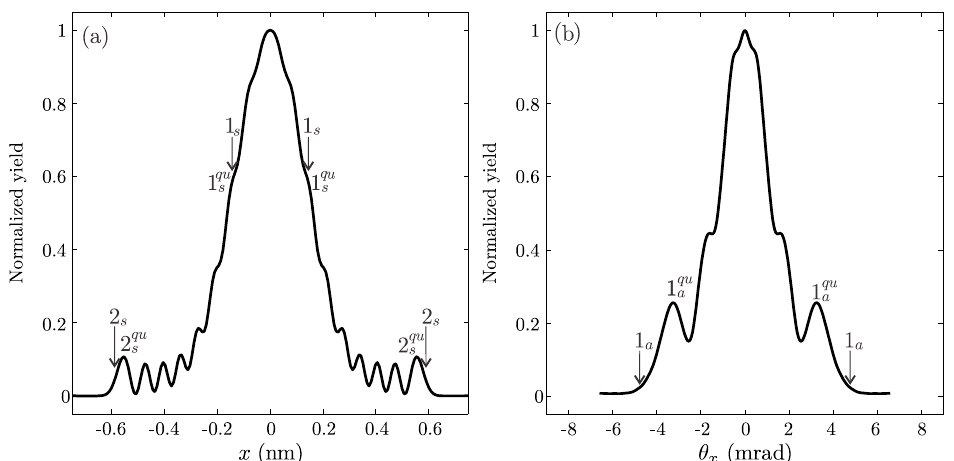
Figure 8. ( a ) The spatial distribution of the 1-MeV positron beam transmitted through SWCNT (14, 4). ( b ) The corresponding angular distribution. Positions of the classical rainbow lines are shown by the arrows.